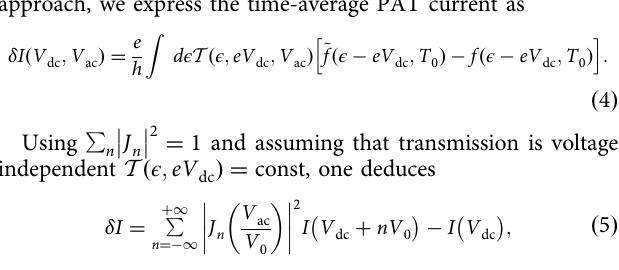
¼ 1 : 52 mV. This value is overestimated by more than four orders of magnitude in view of the laser power (according to Supplementary Fig. 4a, P laser = 53 mW corresponds to V ac ≃ 70 nV). More importantly, equation (1) does not account for the